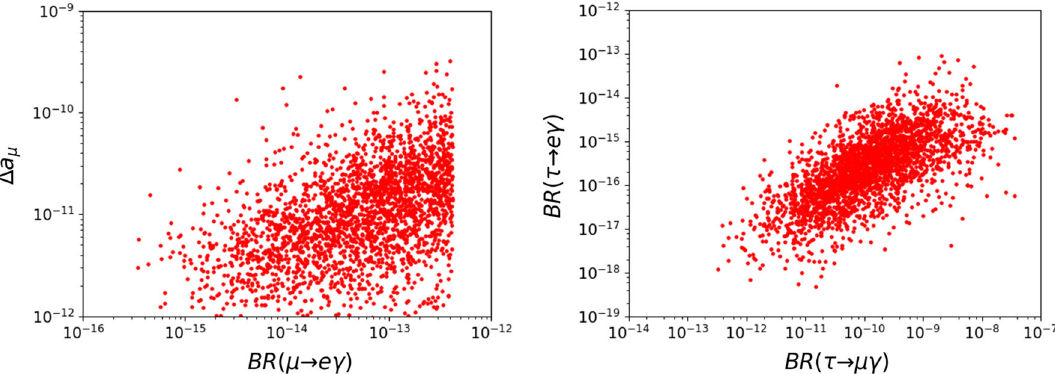
Fig. 4 Allowed region for LFVs and the correlation to muon g − 2. The left one shows muon g − 2 in terms of BR( μ → e γ) , while the right one BR( τ → e γ) in terms of BR( τ →